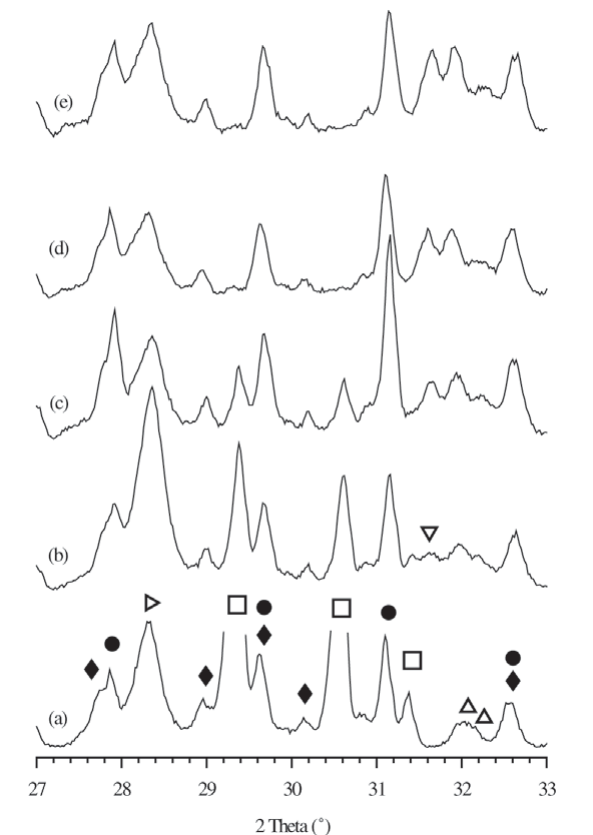
Figure 5. X-Ray diffraction patterns of cement (fine β -TCP; L/P = 1.0 ml/g; 1.0 M Na